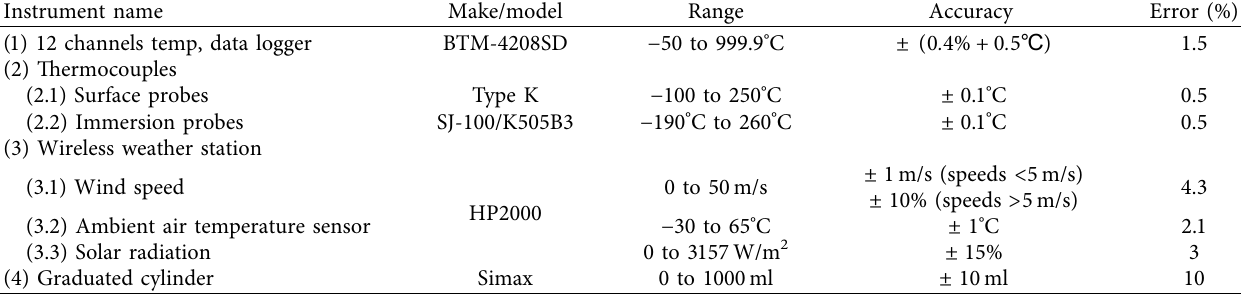
Table 1: Error data for instruments used.